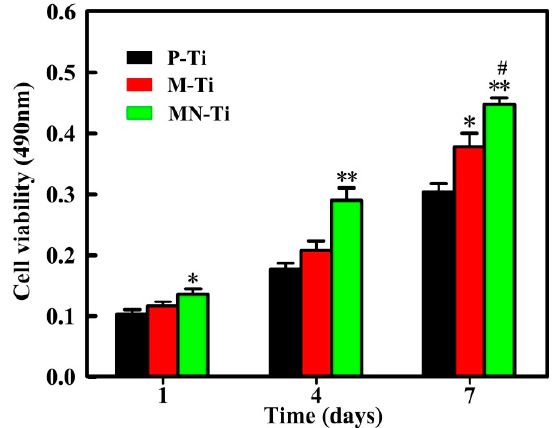
Figure 10. MTT assay of cell proliferation on different Ti samples after 1, 4 and 7 days of culture. # p < 0.05 compared with the M-Ti sample. * p < 0.05 and ** p < 0.01 compared with the P-Ti sample.